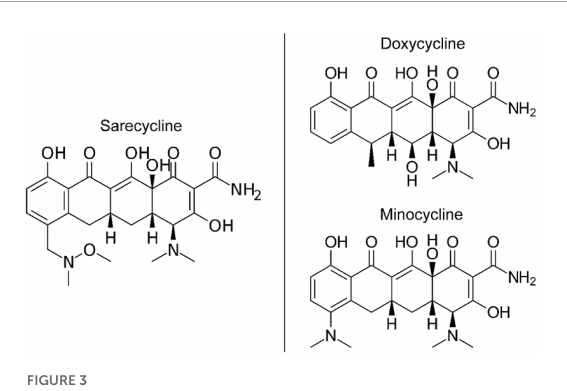
FIGURE3 Chemical structures of tetracycline-class antibiotics